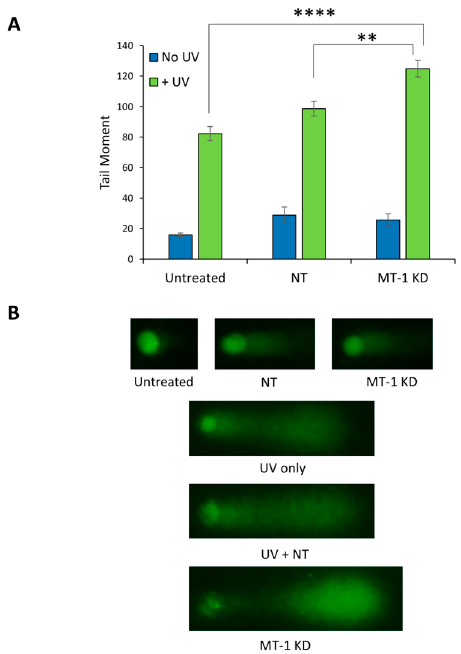
Figure 4. DNA damage is elevated in MT-1 knockdown NHDF exposed to UVA (5 J/cm 2 ) and UVB (40 mJ/cm 2 ). The cells were then assayed for DNA damage by subjecting the cells embedded in agarose to electrophoresis and then staining for DNA with SYBR Gold. An increased length of DNA staining in the immunocytochemistry figures (“comet”) indicates increased damage. Panel ( A ) shows the graphical representation of the “comet tail” and, panel ( B ) shows the actual immunocytochemistry photos (*** p < 0.0001, ** p < 0.01). Error bars are SEM. N = 18.